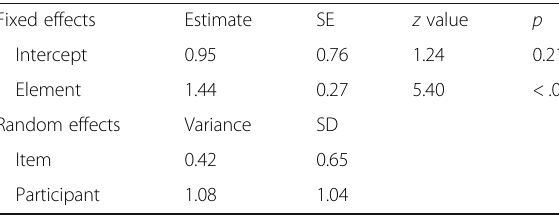
Table 2 Model parameters for the best-fitting model for graph-encoding items